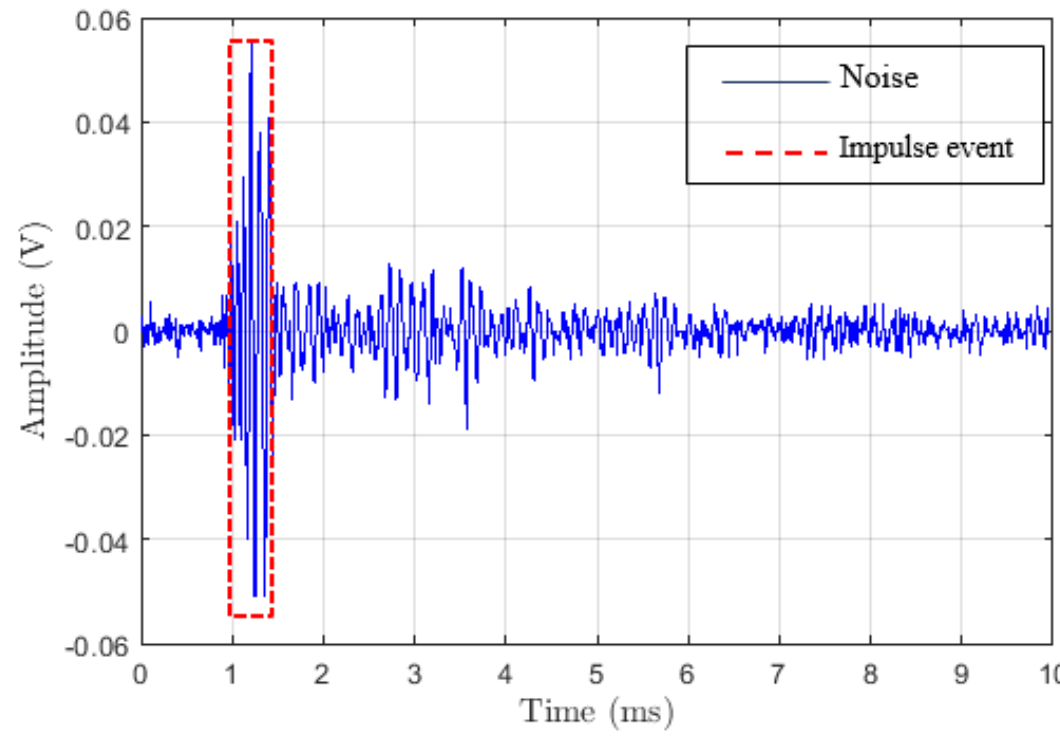
Figure 4. Impulsive noise from the generator bar at 16